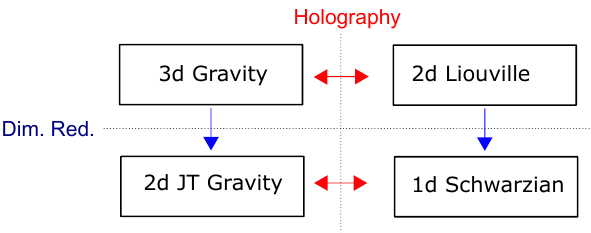
Figure 1 . Relation through holography and dimensional reduction of 3d (cid:3) < 0 gravity, 2d JT gravity, 2d Liouville CFT and 1d Schwarzian QM.